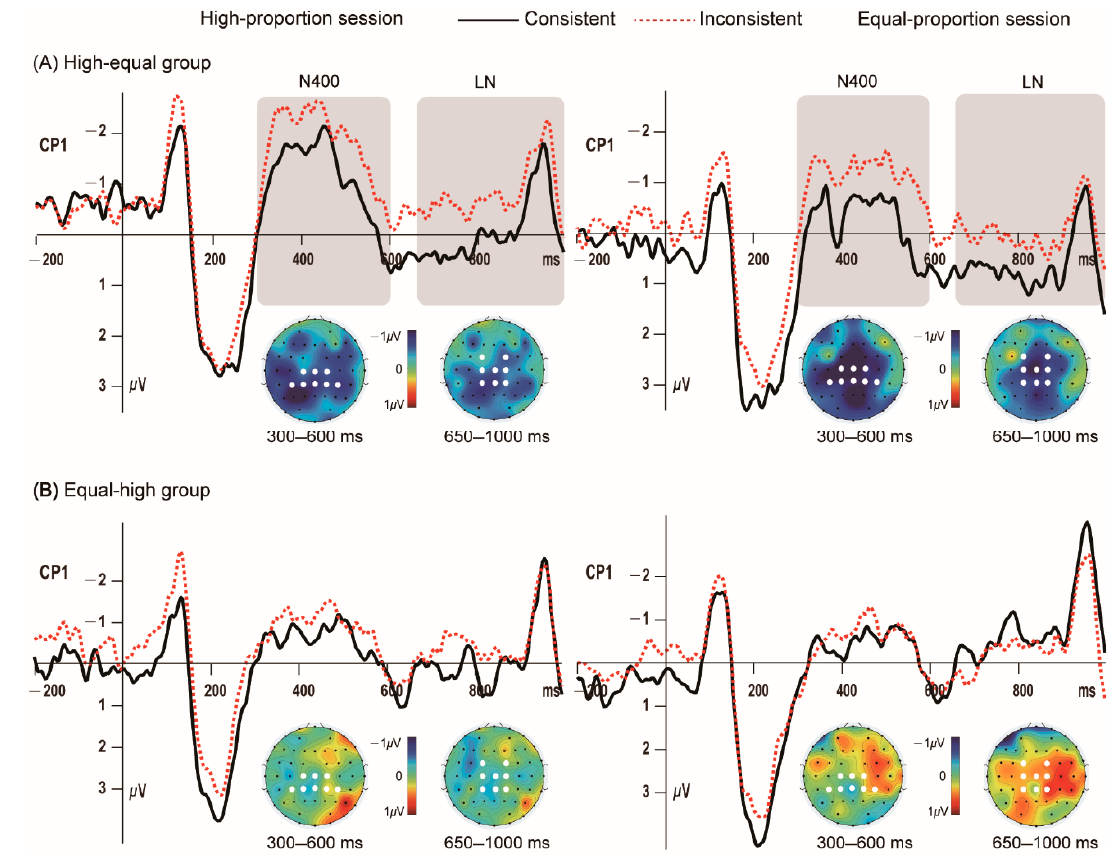
Figure 1. ERPs time-locked to the onset of the role nouns. Grand-average ERP waveforms at CP1, a representative channel, for the consistent and the inconsistent conditions in both high-proportion and equal-proportion sessions for the high–equal ( A ) and the equal–high groups ( B ), respectively. The scalp topographies of the corresponding difference waves (inconsistent minus consistent) are shown for both N400 and late negativity (LN) time windows. The white dots within each topography indicate the locations of all eight channels chosen for data analyses.